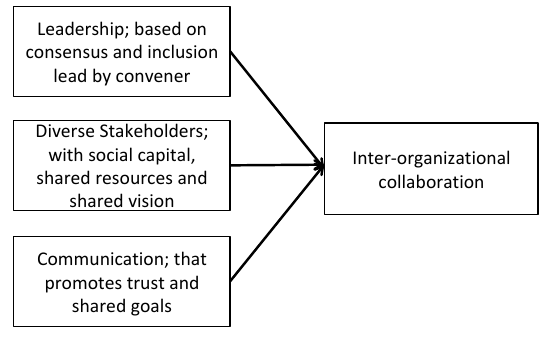
Fig. 1: Theoretical frameworks that facilitate collaboration Leadership - Effective Leadership is perhaps one